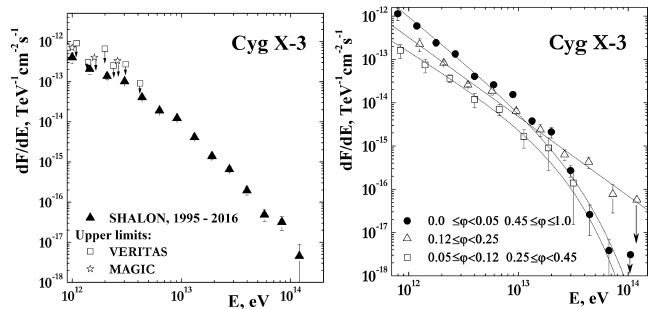
Figure 3. left: Differential spectrum of gamma-ray emission from Cyg X-3 by SHALON ( (cid:78) ); right: The differential spectra of very-high energy γ -rays from Cyg X-3 in different intervals of orbital modulation. The lines represent the fit to each